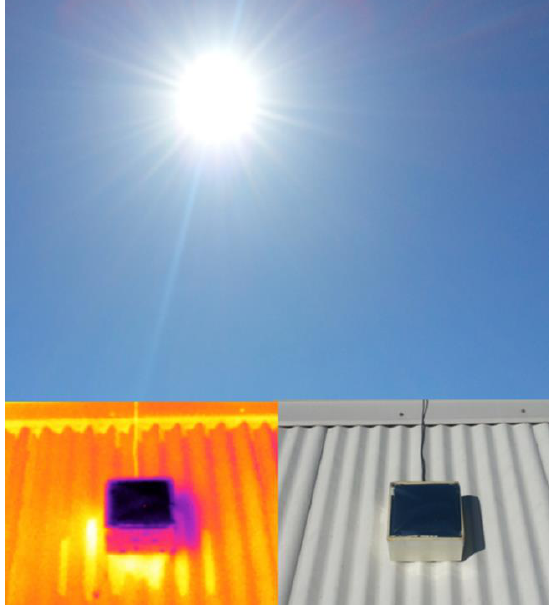
Fig. 1. A thermal image and a visual image of a supercool polymeric nanomaterial under the sky is shown. It is contrasted with a current commercial cool roof. The dark contrast of the coated box indicates that it is radiating significantly less energy than the hot roof on which it is